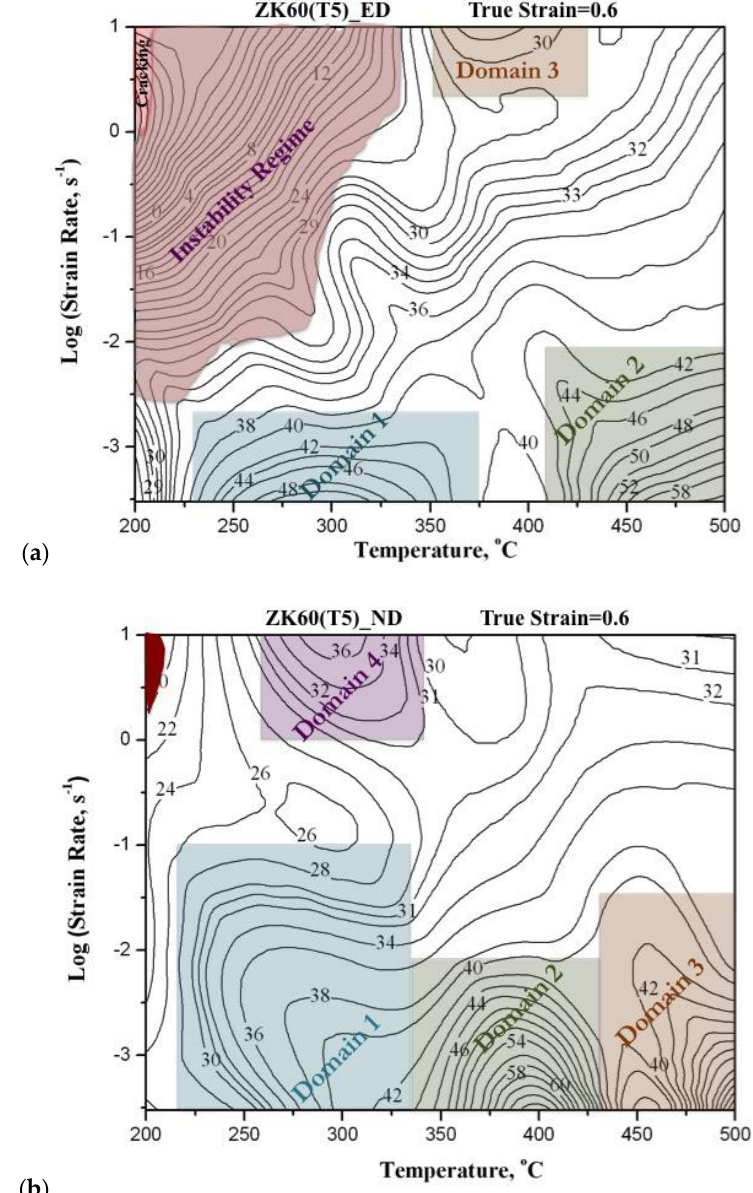
Figure 4. Processing maps obtained for ( a ) ED and ( b ) ND specimens of extruded ZK60-T5 alloy at a true strain of 0.6. The numbers associated with the contours represent the e ffi ciency of power dissipation in